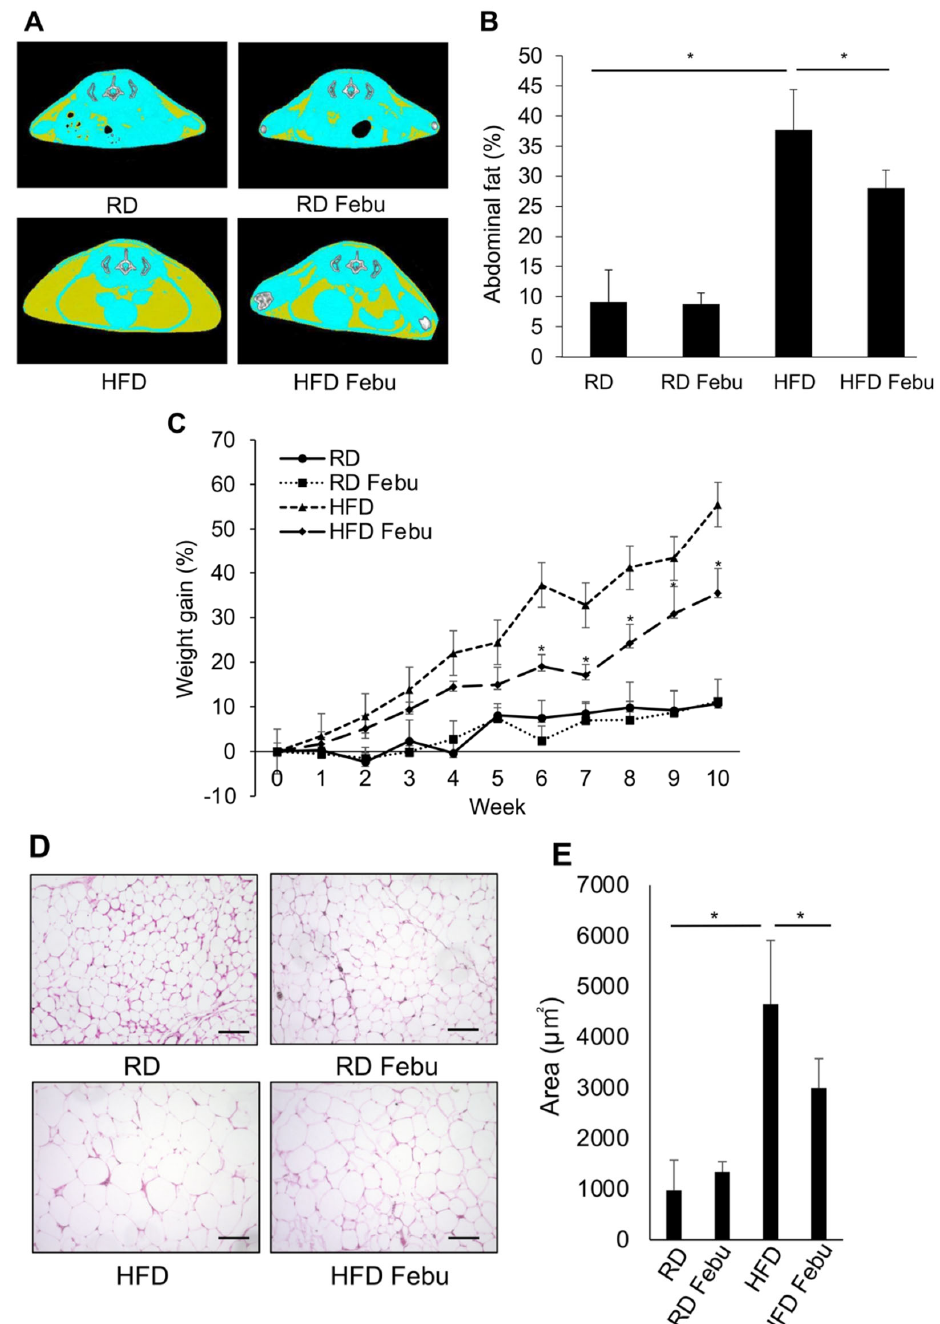
Figure 1. Febuxostat (Febu) ameliorates obesity in high-fat diet-fed (HFD) mice. Regular diet (RD) or high-fat diet (HFD) fed mice were treated for 10 weeks with or without oral administration of Febu. ( A ) Representative micro-CT images of RD and HFD mice with or without Febu treatment are shown. Yellow, adipose tissue; blue, lean mass; white, vertebral bone. ( B ) Quantitative analysis of abdominal fat volume from the level of 1st to 6th lumbar vertebrae using micro-CT images at 10 weeks. n = 5 per group. Results are expressed as the mean ± SD. * p < 0.05. ( C ) Percent increase in body weight from baseline in RD and HFD mice with or without Febu treatment is shown. n = 5 per group. Results are expressed as the mean ± SD. * p < 0.05 vs. HFD at the indicated time point. ( D ) Representative images of hematoxylin and eosin (H&E) staining of the visceral white adipose tissue. Original magnification, × 200. Bar, 100 µ m. ( E ) The area of adipocytes was measured. n = 5 per group. Results are expressed as the mean ± SD. * p <